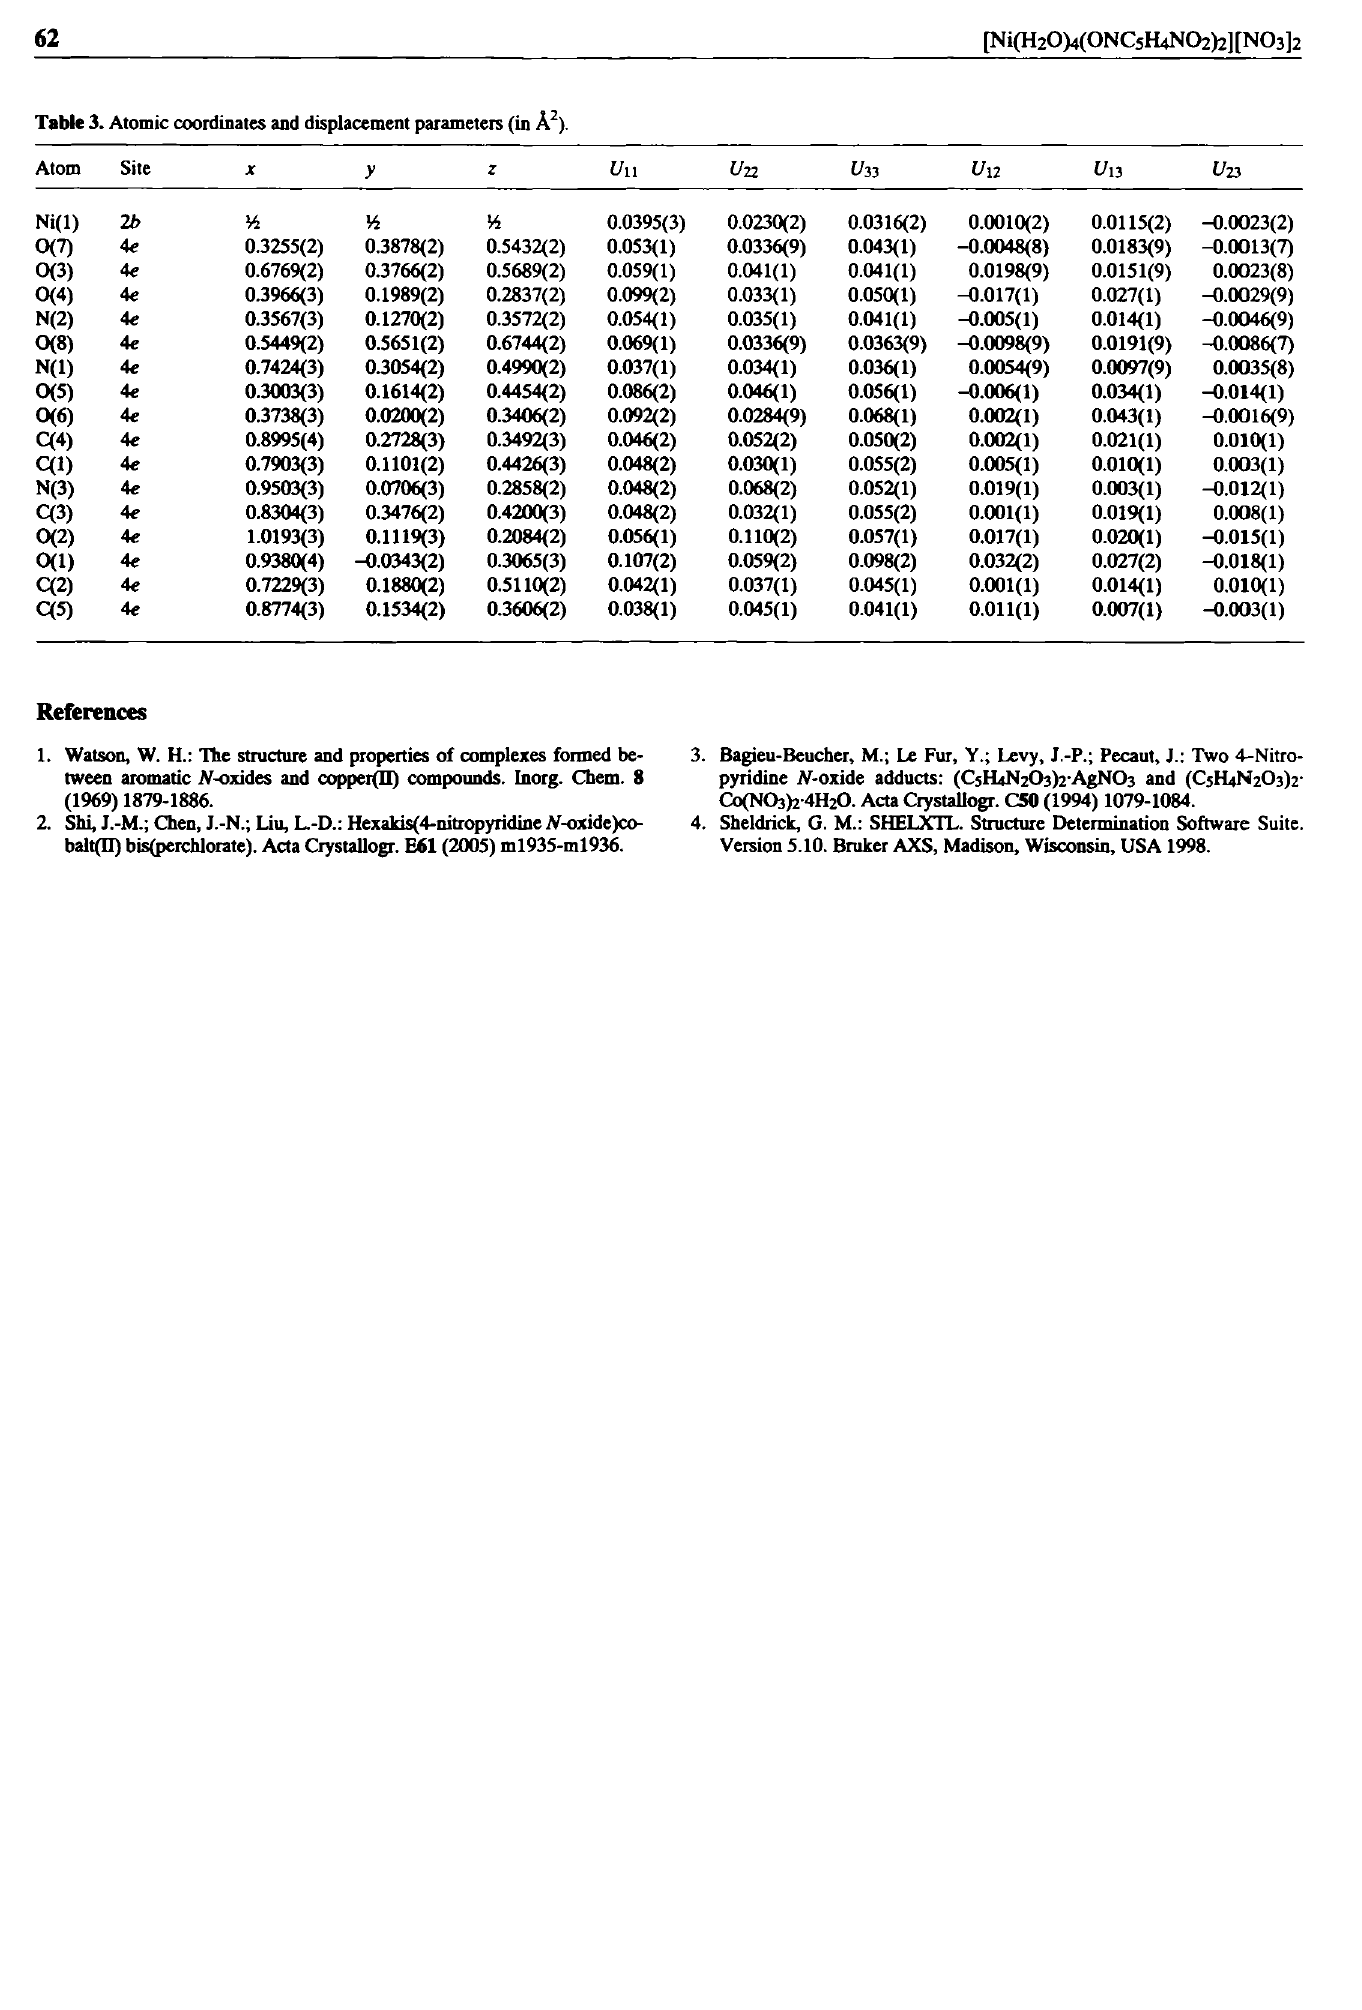
Table 3. Atomic coordinates and displacement parameters (in A 2